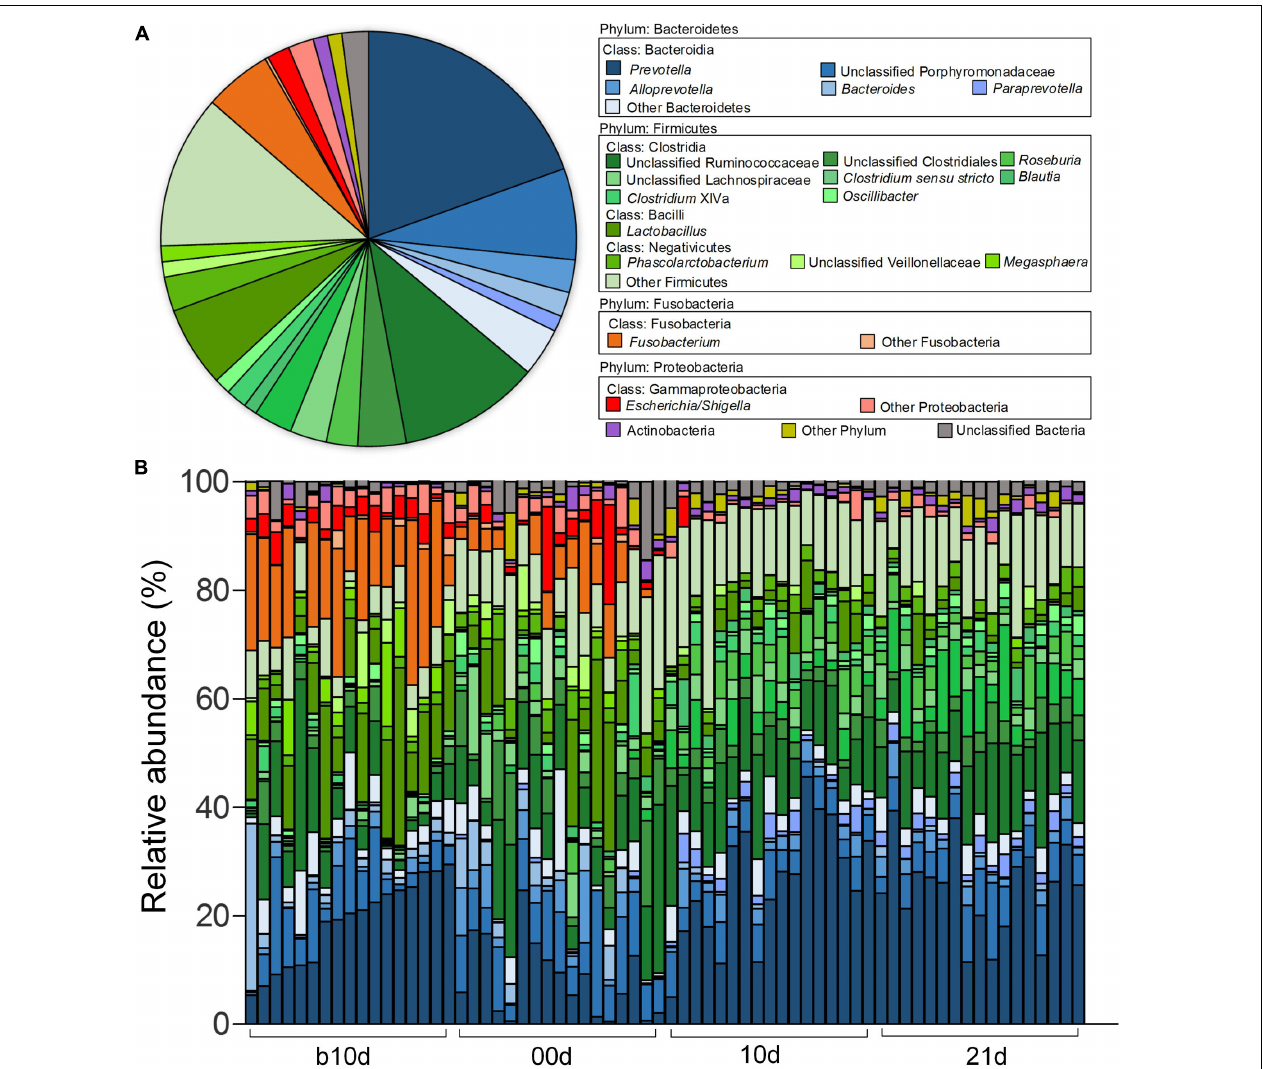
FIGURE 1 | Genus-level gut microbiota composition of the piglets. (A) The dominant genera (1% of the total sequences) in the 68 fecal samples of piglets. (B) Relative contribution of these dominant genera in each sample. Samples are arranged according to the proportion of Prevotella (the most dominant genus) in b10d and paired sample in other three sample collected time